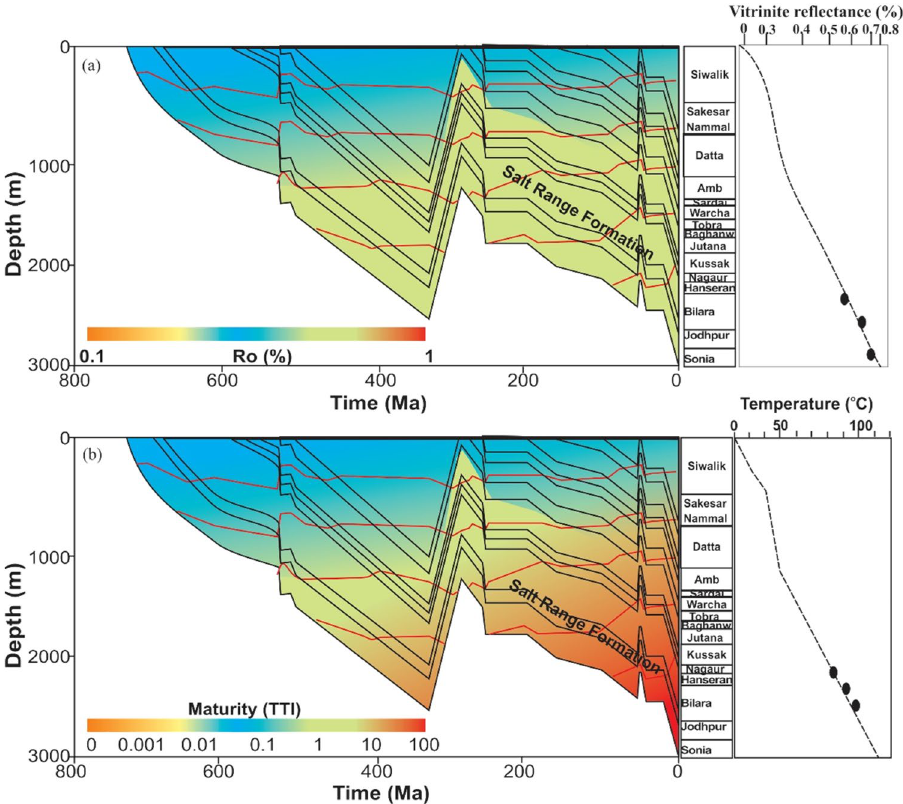
Figure 7. Burial history and thermal modeling of Infracambrian rock: ( a ) vitrinite reflectance, and ( b ) maturity